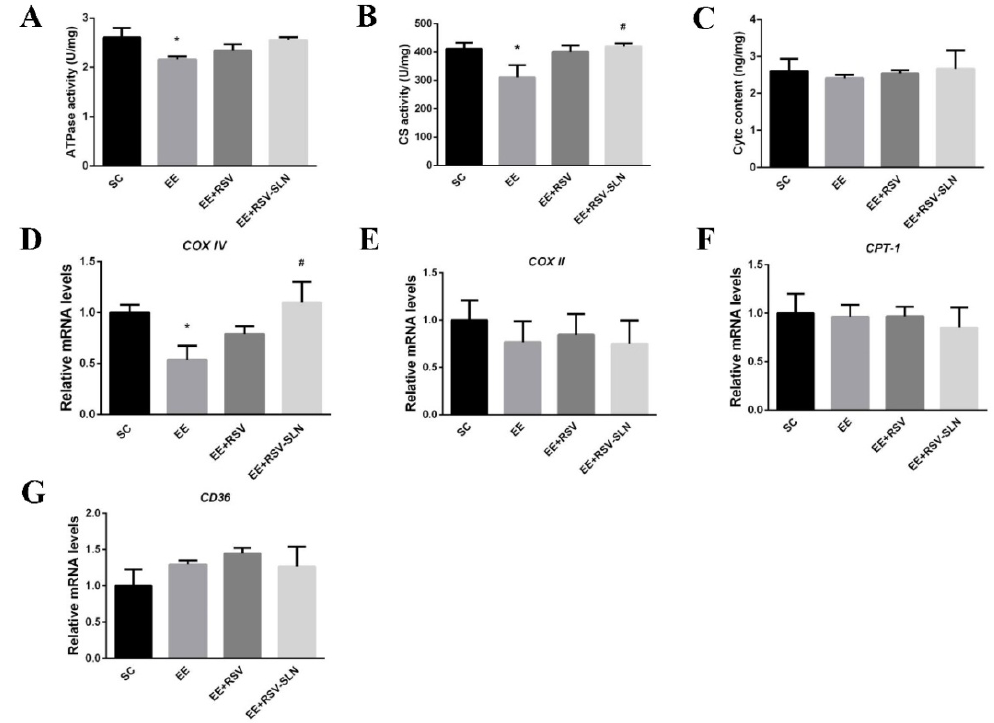
Figure 6. RSV-SLN alleviates mitochondrial dysfunction but does not alter mitochondrial long-chain FA translocase during excessive endurance exercise. ( A ) ATPase activity. ( B ) CS activity. ( C ) Cyt c content. ( D , E ) mRNA expression levels of COX IV and COX II . ( F , G ) mRNA expression levels of CPT-1 and CD36 in the skeletal muscle from four groups of mice. * p < 0.05 vs. SC group; # p < 0.05 vs.